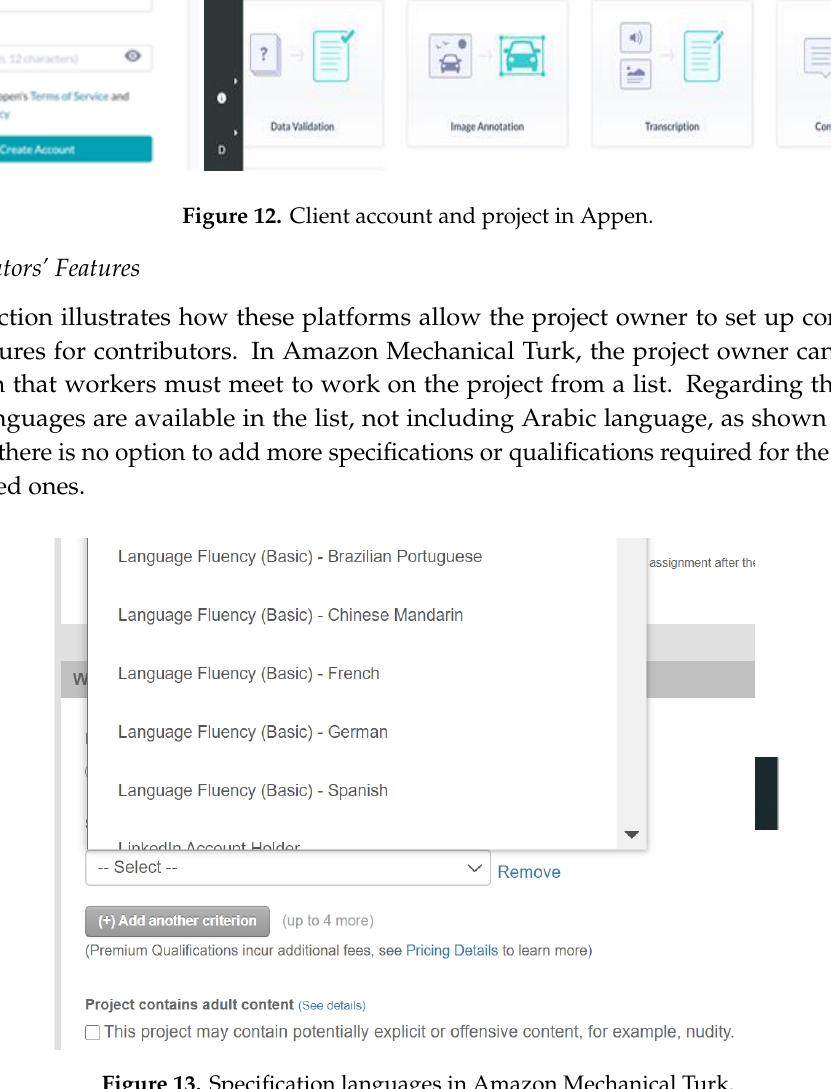
Figure 13. Specification languages in Amazon Mechanical Turk.